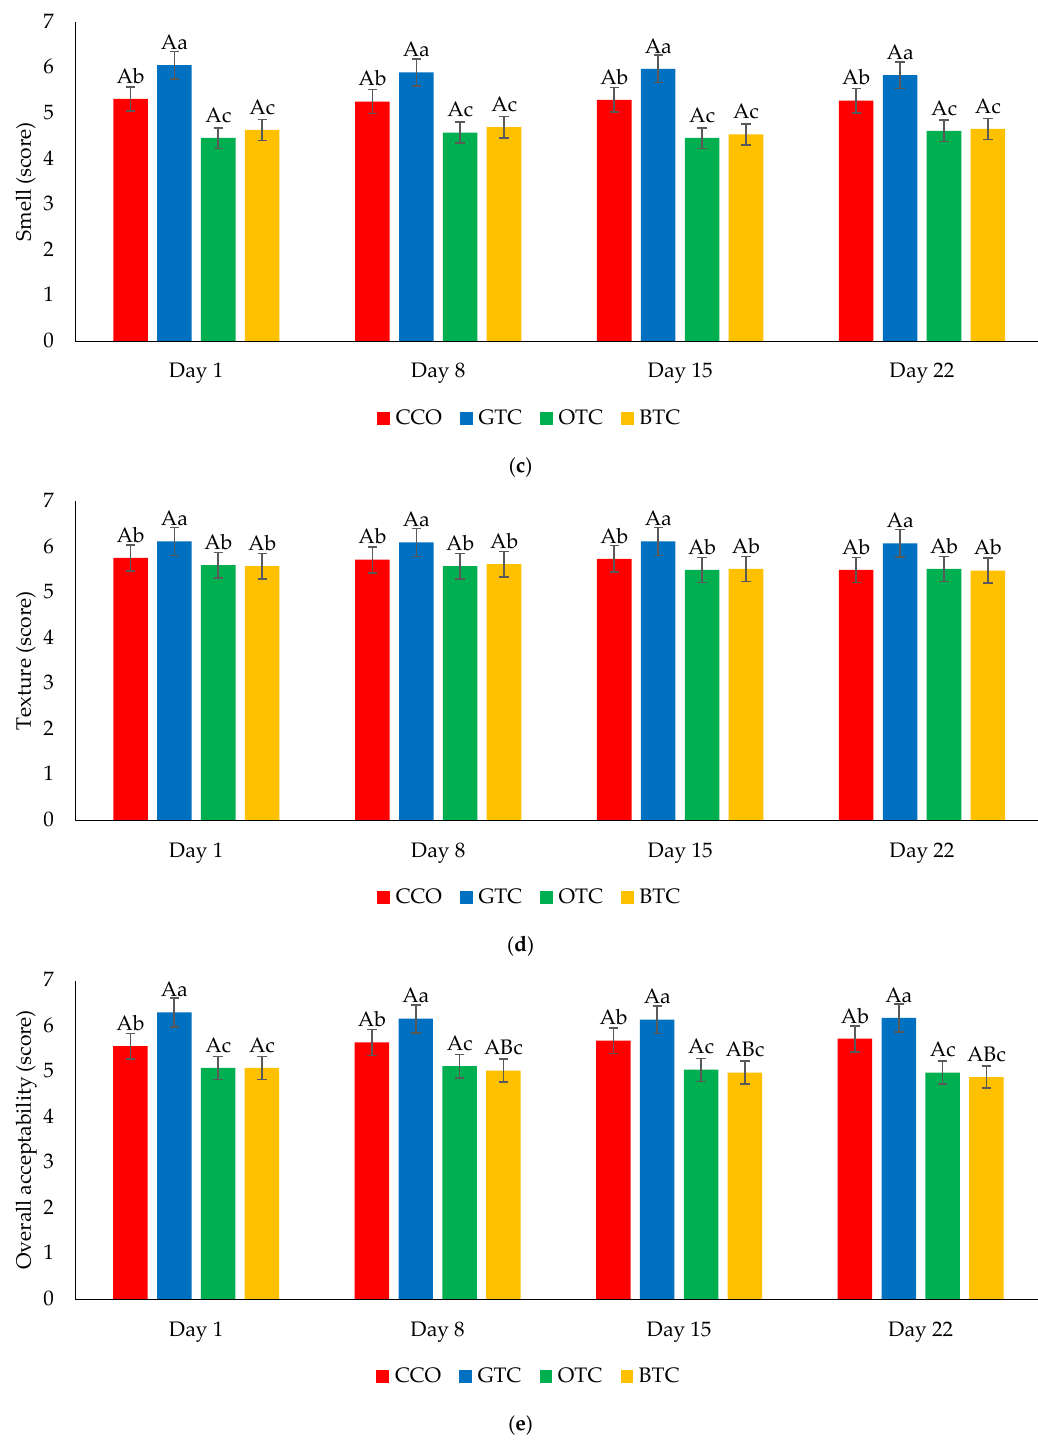
Figure 8. The sensory properties ( a ) appearance, ( b ) taste, ( c ) smell, ( d ) texture, and ( e ) overall acceptability of non-gluten shortbread cookies with various spent tea leaf powders during different storage periods (day 1, 8, 15, and 22) at 25 ◦ C. The mean ± SD ( n = 3). Different letters indicate significant differences between the values (Duncan’s multiple range test, p < 0.05, a–c cookie samples, A,B storage). CCO = control; GTC = non-gluten shortbread cookie with spent green tea leaves powder; OTC = non-gluten shortbread cookies with spent oolong tea leaves powder; BTC = non- gluten shortbread cookies with spent black tea leaves powder; 1 = extremely dislike; 2 = moderately dislike; 3 = slightly dislike; 4 = neither like nor dislike; 5 = slightly like; 6 = moderately like; and 7 = extremely